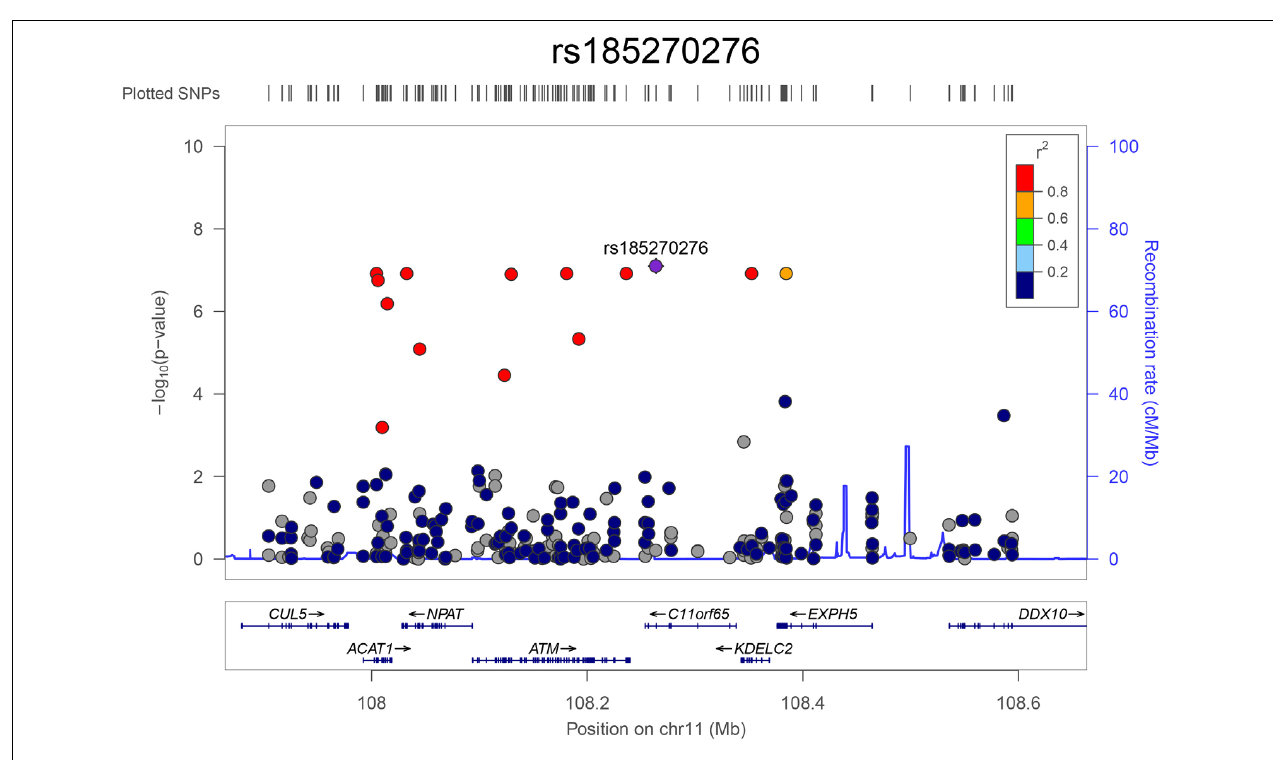
FIGURE 3 | Regional association plot for the top hits on chromosome 11. The plot was constructed using LocusZoom (http://locuszoom.org/). The –log10 transformed p -values are plotted on the y -axis. The x-axis shows the position of the variants (dots) on chromosome 11 and the genes in this region. The most significant variant (rs185270276) is shown in purple and the color of the dots indicates the extend of linkage disequilibrium between the variant and the top variant.